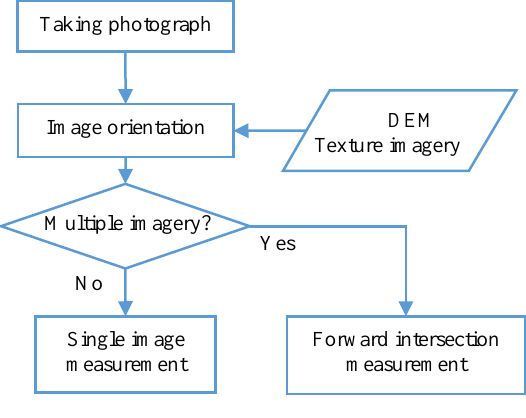
Figure 1. Processing flow of this